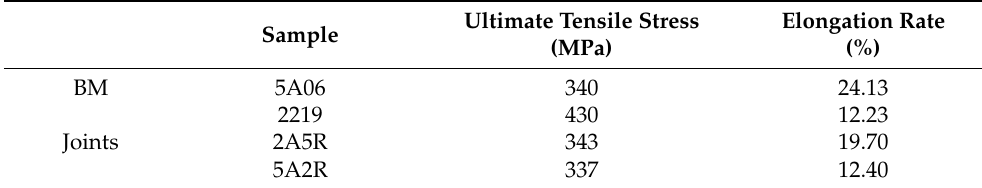
Figure 7. Stress–strain curves of the tree welding joint with one welding parameter (rotational speed of 800 rpm and welding speed of 100 mm/min): ( a ) 2A5R, ( b ) 5A2R. Table 3. Tensile properties of FSWed joints (welding speed of 100 mm/min, 0.6 mm load-depth and rotational speed of 800 rpm).